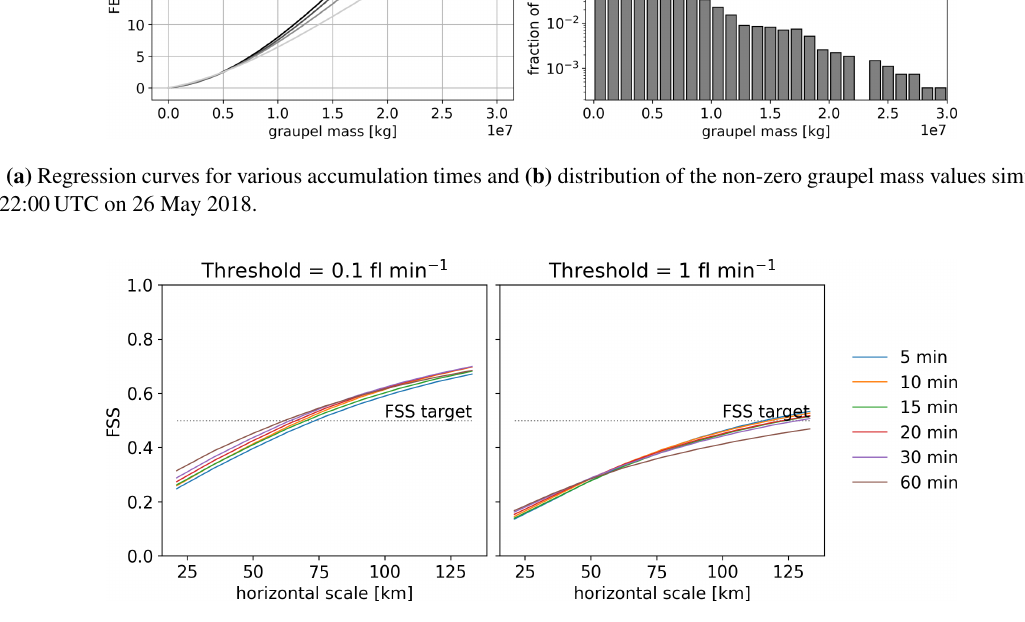
Figure 20. FSS for the bow echo lifetime period, 13:00 to 22:00UTC on 26 May 2018, for all the accumulation times tested with two different